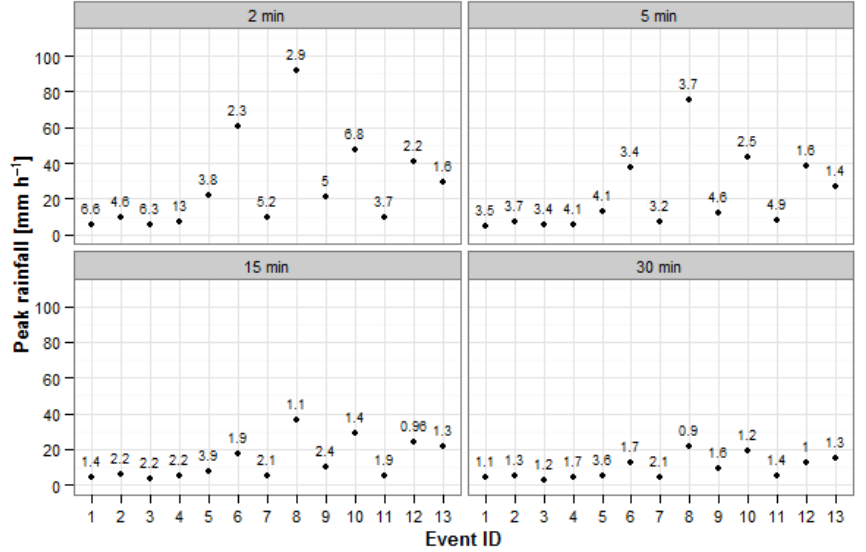
Figure 11. Predictions of event peaks of AARI (indicated by points) together with labels indicating corresponding CV (%) values.